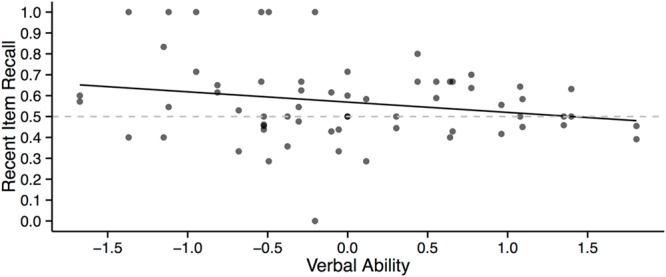
Relationship between verbal ability and recent item recall. The proportion scores reflecting recent item recall were logit transformed before entering them into the correlation analysis, however, we plot raw proportion values for easier interpretation.